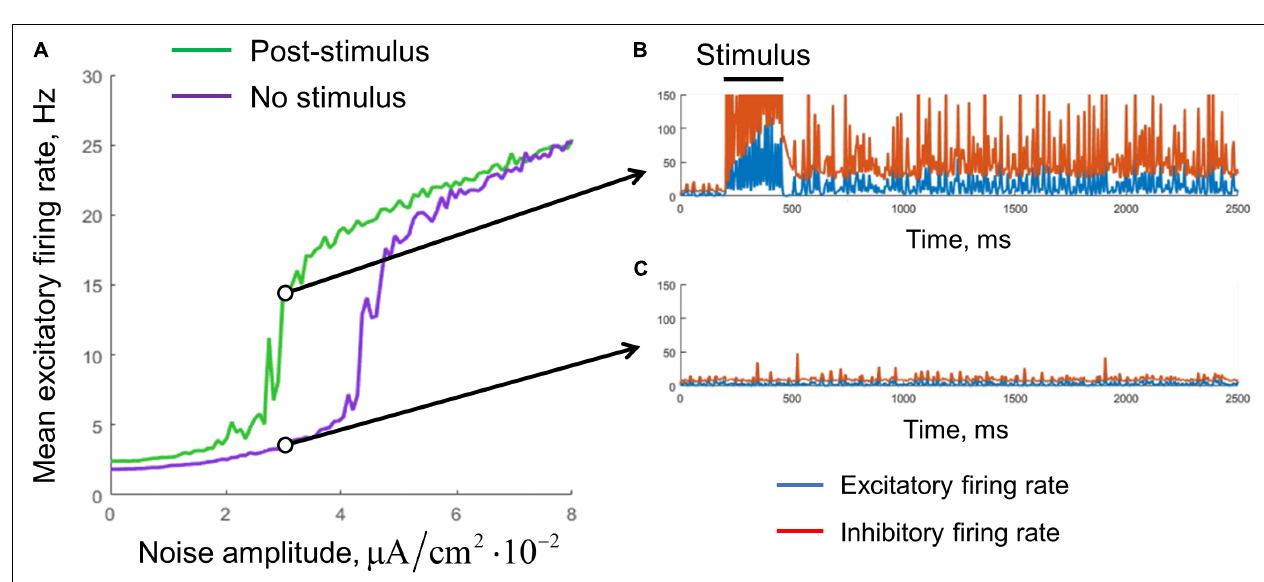
FIGURE 3 | Resonant stabilization of the metastable activity by a sinusoidal signal (without noise) in the single-circuit model. In panel (A) , there is a diagram showing the mean excitatory firing rate for different values of the amplitude and frequency of the signal. Simulation was performed for 10 s, and the firing rate was averaged over the last period of the input signal. Above the solid red curve, the active (initially metastable) regime is persistent; above the dashed red curve, there is no background regime. (B–D) Examples of the activity traces. Blue, excitatory firing rate; red, inhibitory firing rate. The system was shifted to the metastable active regime by a transient constant input (stimulus), after which an oscillatory input was turned on (20, 40, or 60 Hz zero-mean sinusoid). Note that the 40 Hz periodic input (C) provided a persistent active regime.